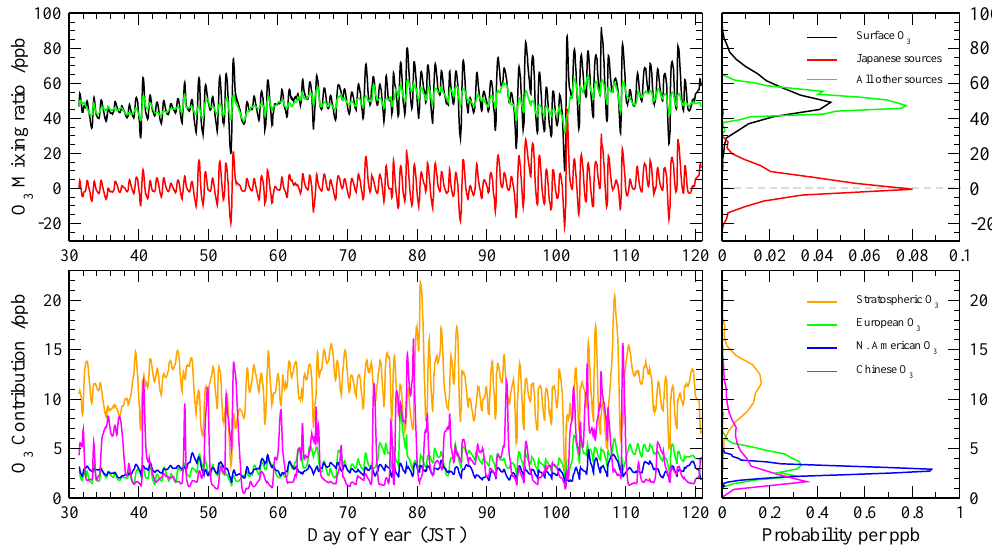
Fig. 6. Hourly mean surface O 3 mixing ratios in Tokyo in February–April 2001 from the FRSGC/UCI CTM showing (a) total surface O 3 (black), O 3 from Japanese sources (red) and the difference between them (representing O 3 from all other sources; green), and (b) contributions to O 3 from Chinese (magenta), European (green) and North American (blue) sources and from the stratosphere (orange). Right-hand panels show the probability distribution over the three-month period.